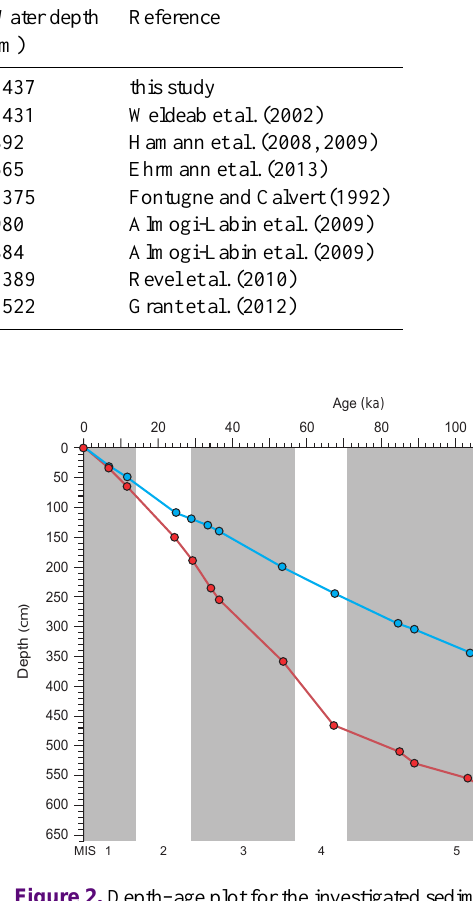
Table 1. Metadata for the investigated sediment core GeoTü SL110 and other cores mentioned in the text (cf. Fig. 1).